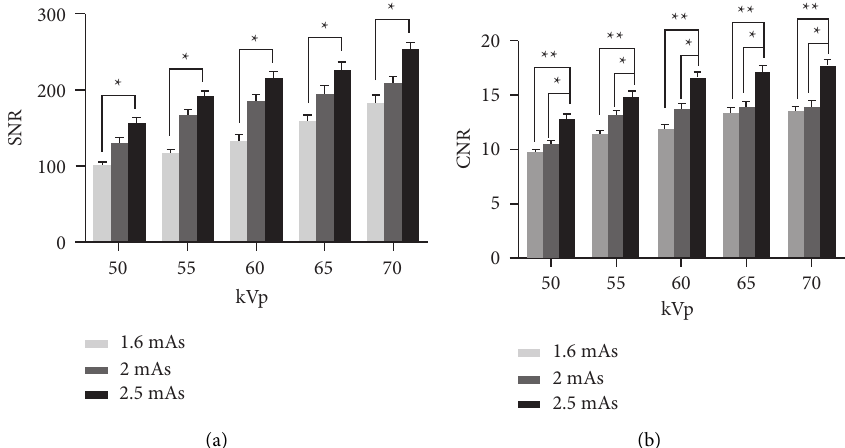
Figure 4: An increase in SNR (a) and CNR (b) as the exposure technique (kVp and mAs) increase. The asterisk indicates a significant difference ( ∗ p < 0 . 05).